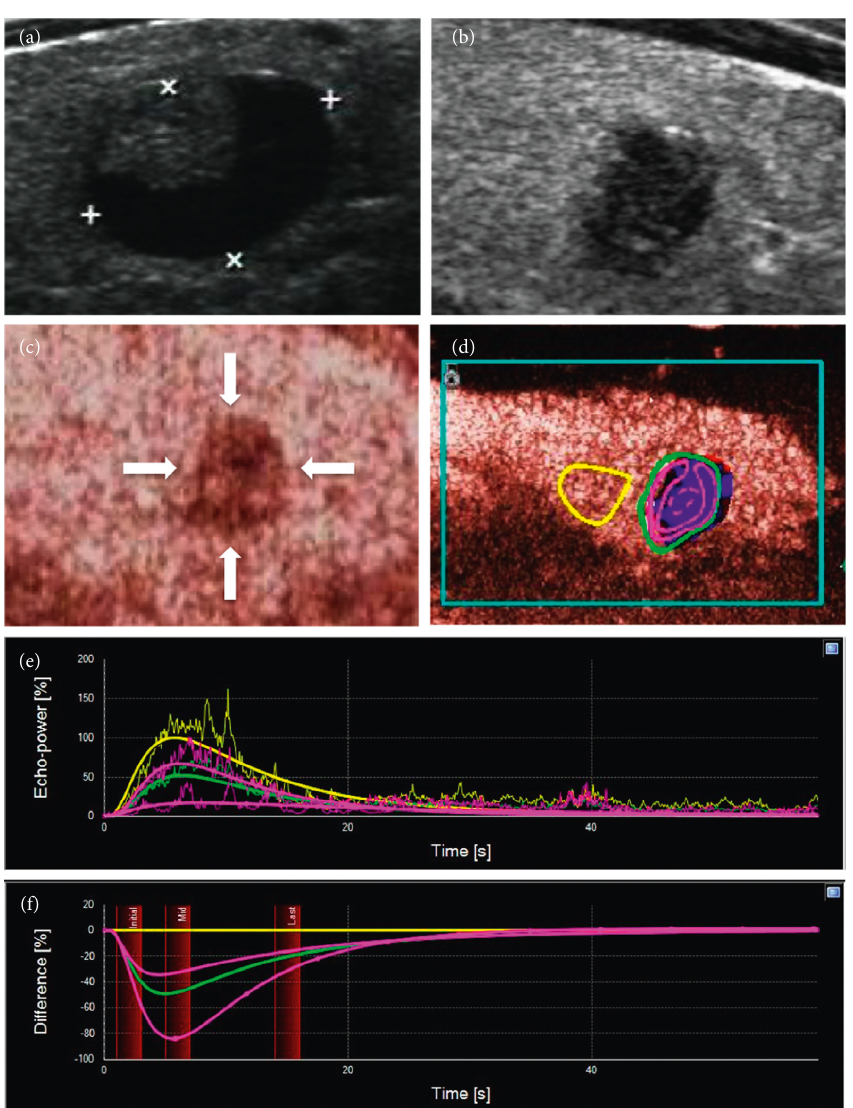
Figure 5: (a) This thyroid nodule had clear margin, and its maximum diameter was 15 mm, which was classified as TI-RADS 3. (b) Five years later, the patient reexamined the thyroid and was found that the nodule had become smaller and more solid, with irregular margin, microcalcifications at the edge, and a taller-than-wide shape, which could be classified as TI-RADS 5. (c) CEUS showed that the contrast mode was enhanced from the periphery to interior. It was uneven with low enhancement, and the margin was not very clear, so it was difficult to distinguish it from a PTC. (d–f) SonoLiver software was used to analyze the contrast video, and the time intensity curve conformed to the performance of mummified